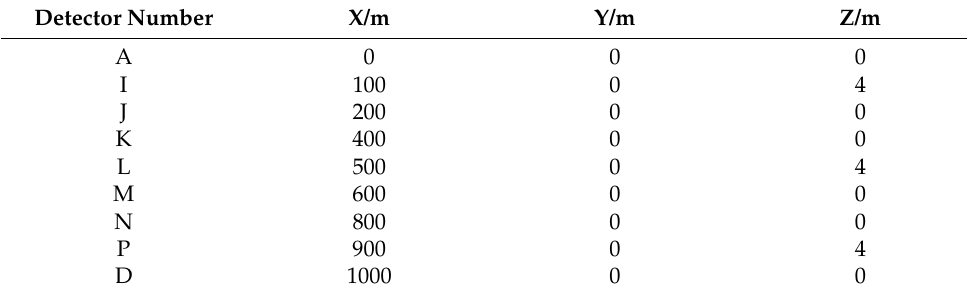
Table 2. 3D coordinates of non-benign array detectors.